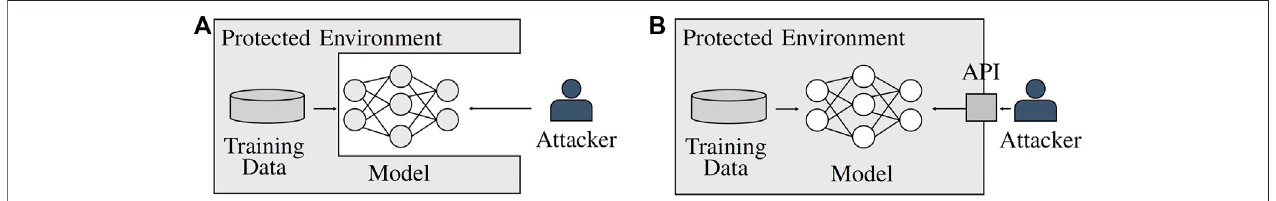
FIGURE2| AccessscenariosforMLmodels. (A) Awhite-boxsettingallowstheattackerfullaccesstothemodelandallofitsparametersbutnot(necessarily)tothe model ’ s training data. (B) In a black-box scenario, the attacker has no direct access to the model but instead interacts with it over an application programming interface (API).